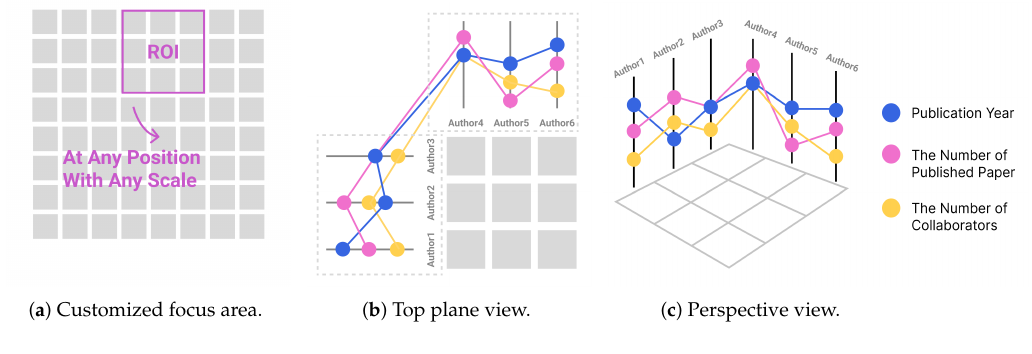
Figure 3. Details of